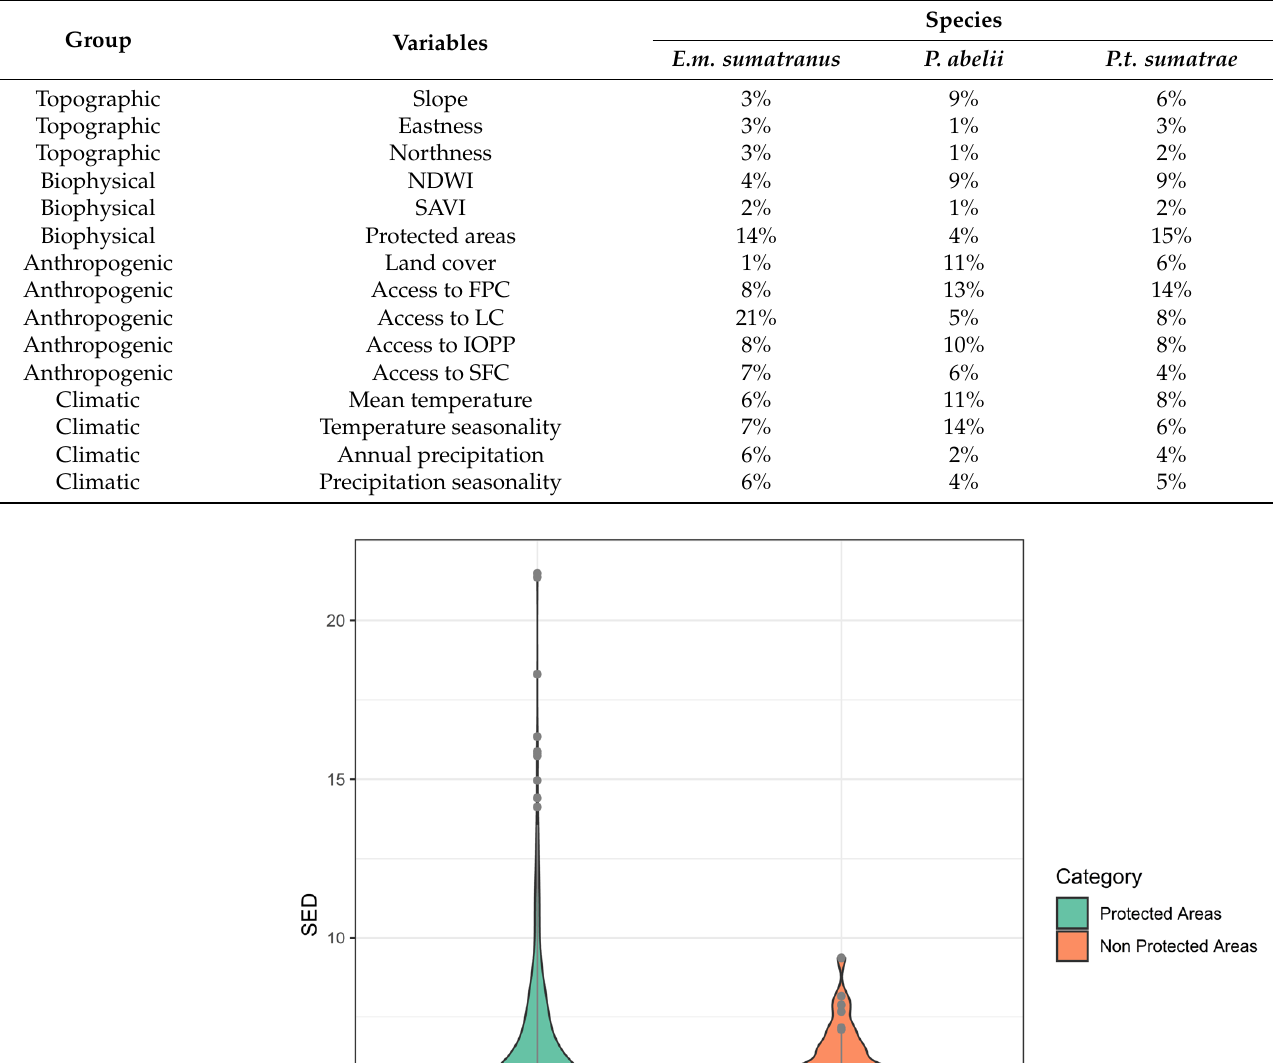
E.m. sumatranus , Figure 3B: P. abelii , Figure 3C: P.t. sumatrae ). The area of suitable